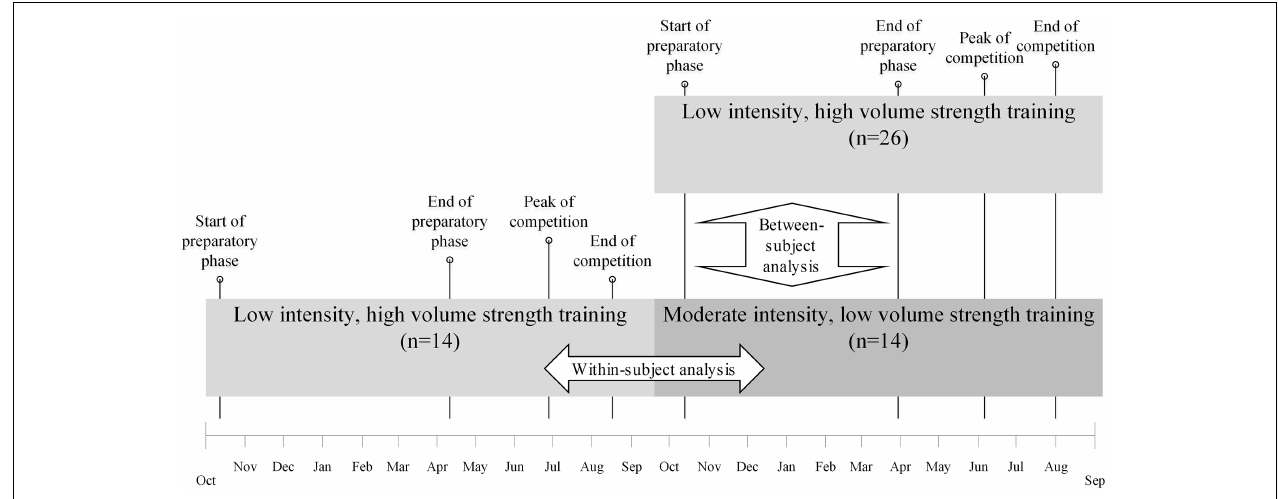
FIGURE 1 | Graphic of study design. The boxes indicate when training conditions were performed on the time scale below. Vertical lines indicate the timing of measurement occasions and the corresponding seasonal phases.